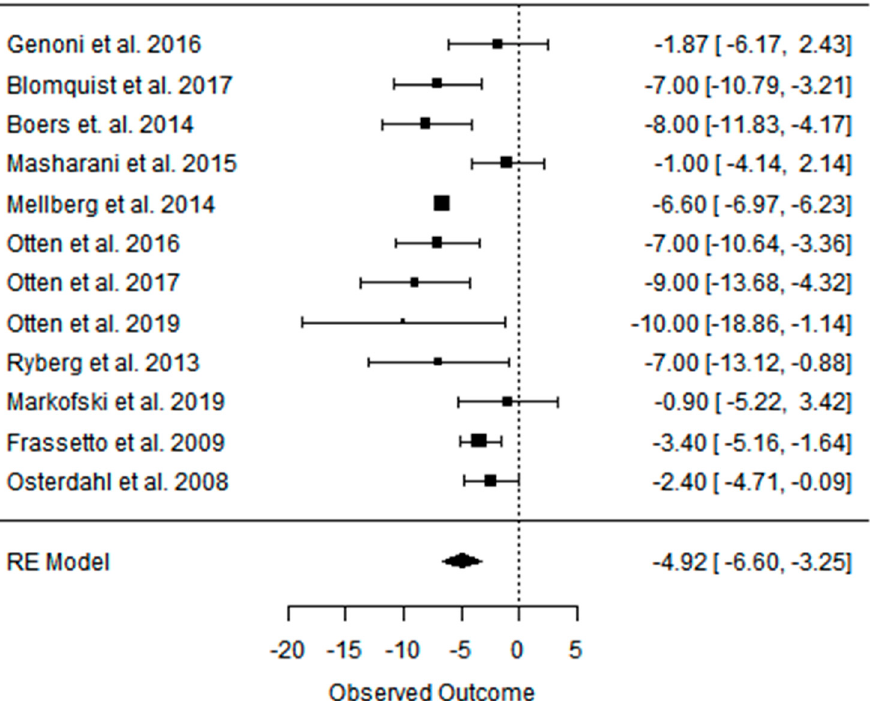
Figure A37. Forest plot of the effect of a PDs on DBP in the short term (weighted mean difference).